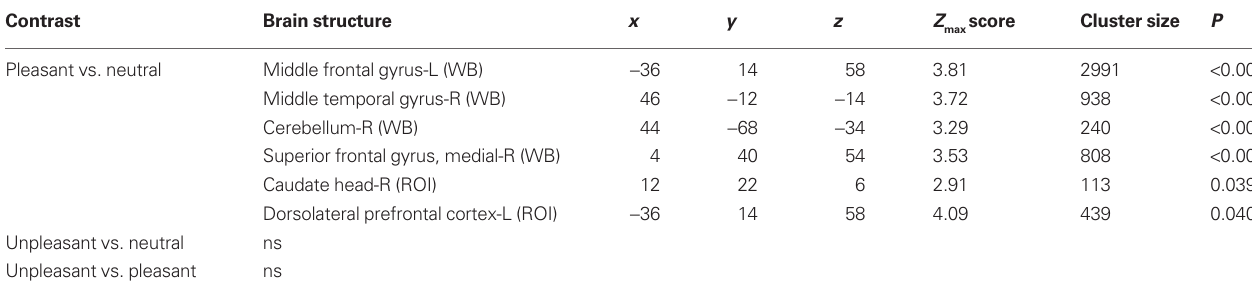
Table 2 | Significant correlations with valence ratings revealed by whole brain (WB) and regions of interest (rOi) analysis. Contrast